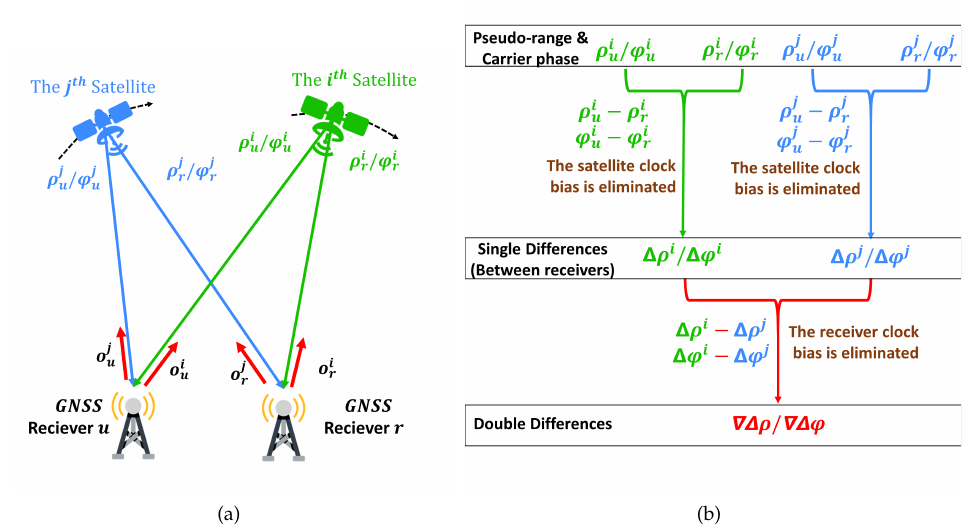
Figure 2. SD measurements and DD measurements. ( a ) Two receivers track the signals of two satellites. ( b ) Steps to calculate SD measurements and DD